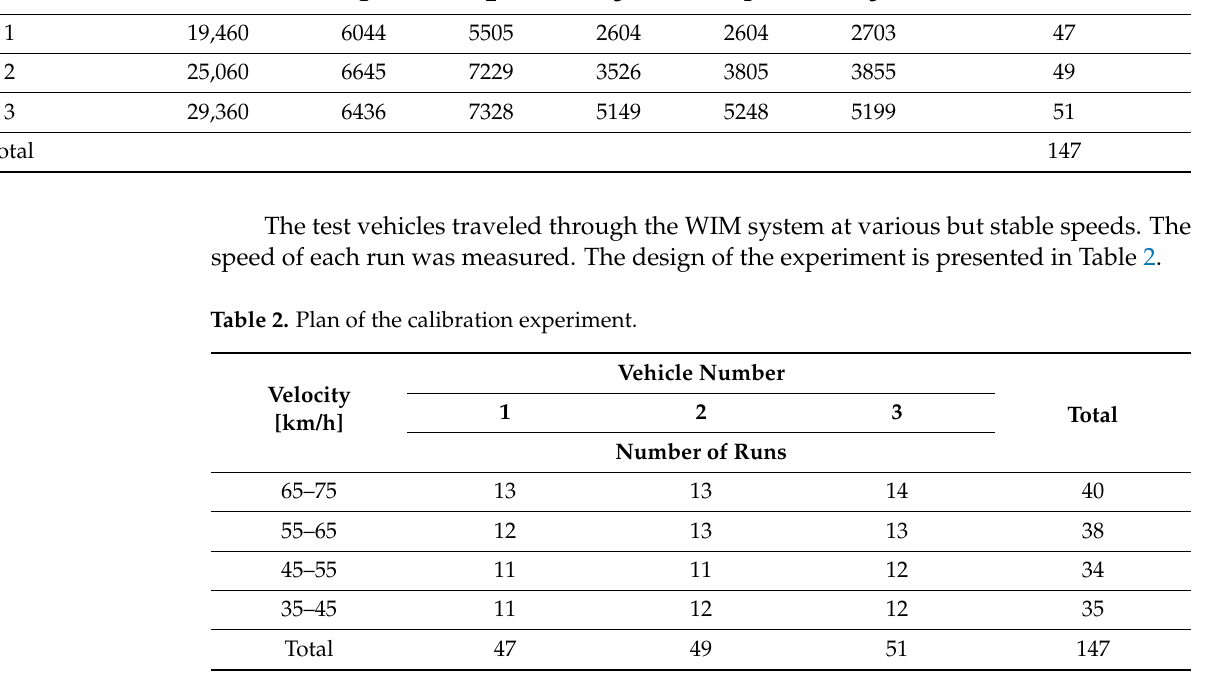
Figure 6. Illustration of the method for selecting parameters of the calibration process for the as- sumed, permissible error of weighing.